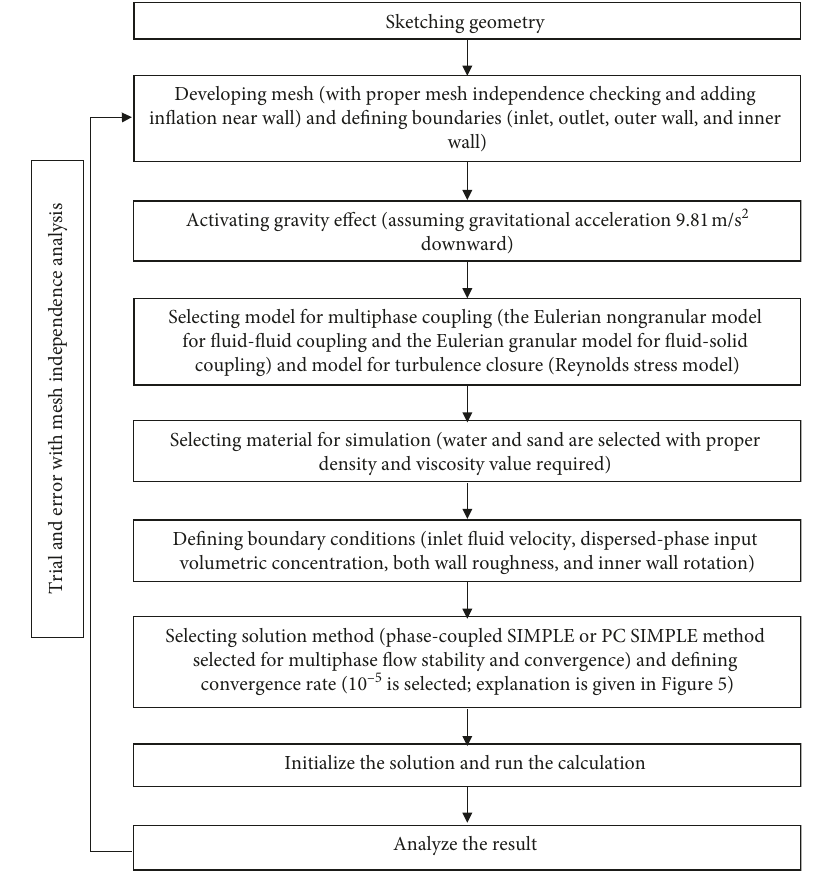
Figure 1: Simulation process diagram.